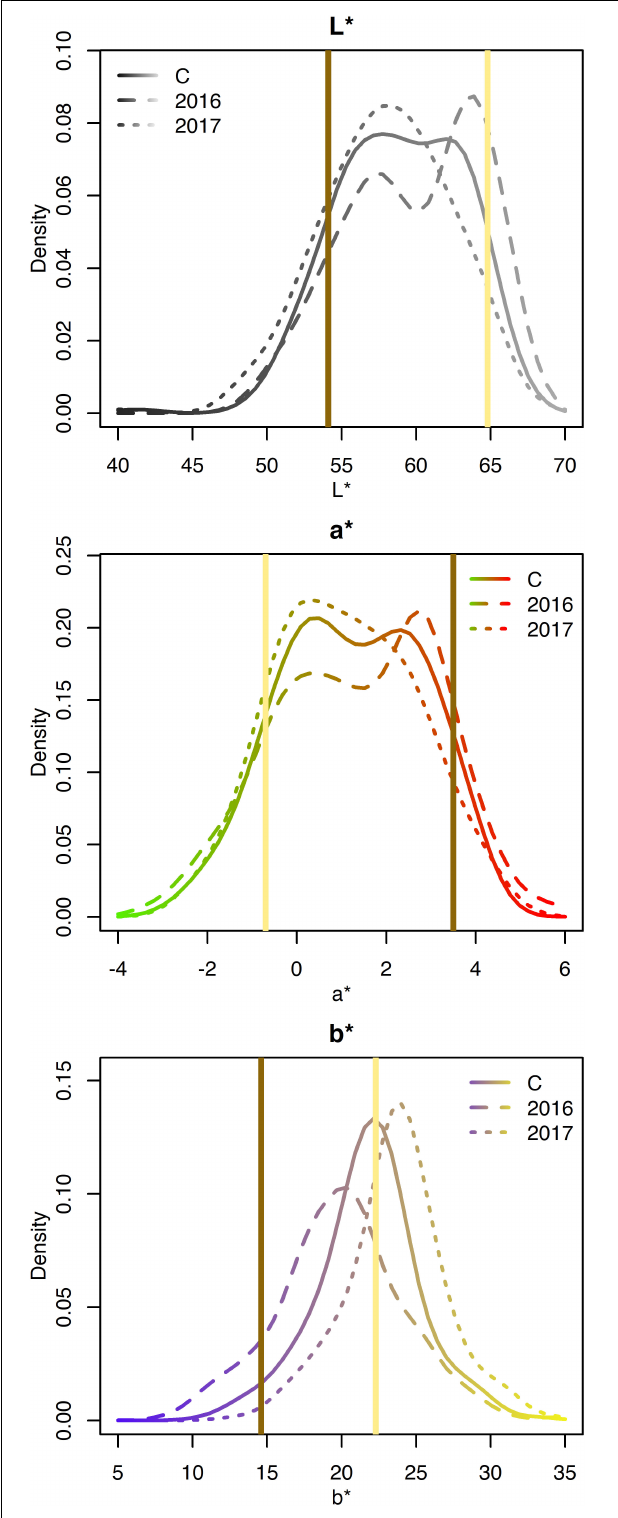
FIGURE 4 | Density plots of CIELAB values for the RILs from 2016, 2017, and both years combined (C). Attribute intensities for Ervilha and PI527538 from both years combined are indicated in yellow and brown,